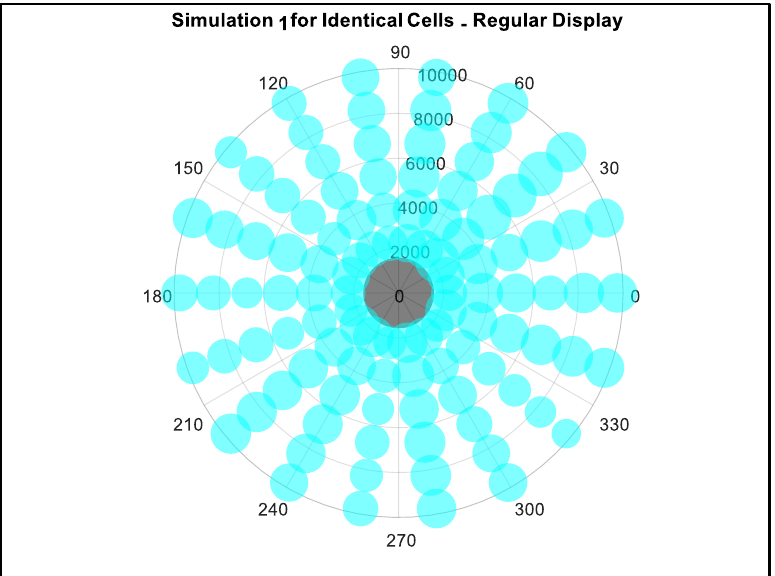
Figure 4. Simulation 1 for identical cells — display of the general results.